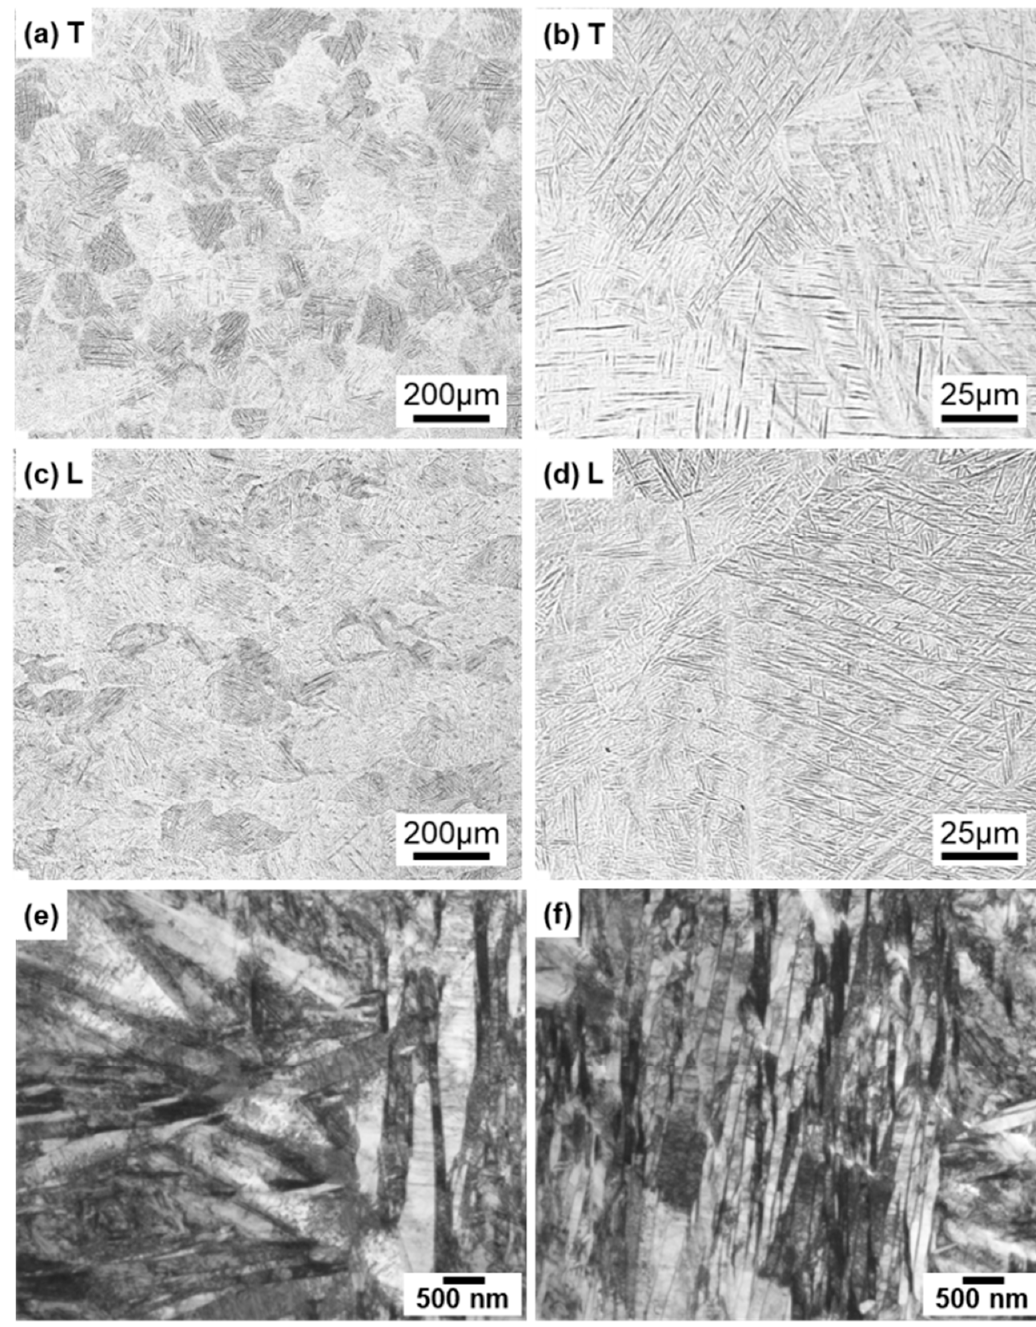
Figure 6. Optical microscopy images of once-sintered Ti-6Al-4V alloys built in 90° direction; ( a , b ) transverse (T) sections to the building direction and ( c , d ) longitudinal (L) sections perpendicular to the building direction; ( e , f ) TEM images of transverse section of once-sintered Ti-6Al-4V alloys built in 90° direction.